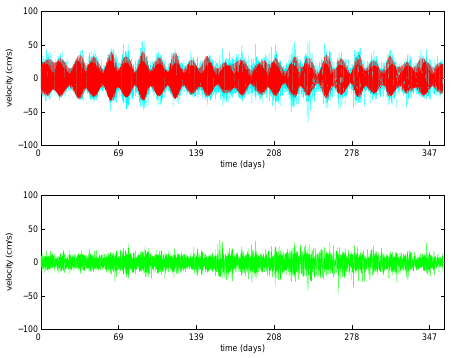
Fig. 3. High frequency data (cyan), tidal data (red) and surge data (green) are shown for u component at location NA, 170m